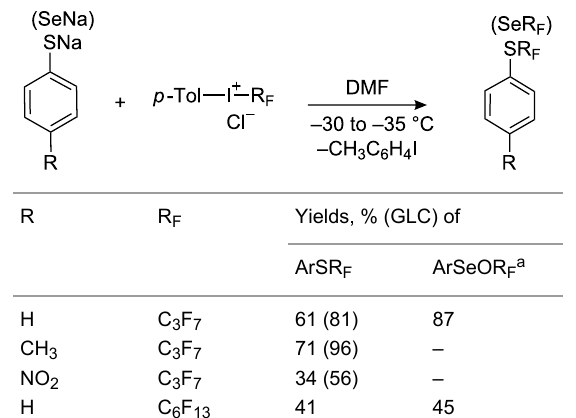
R R F Yields, % (GLC)